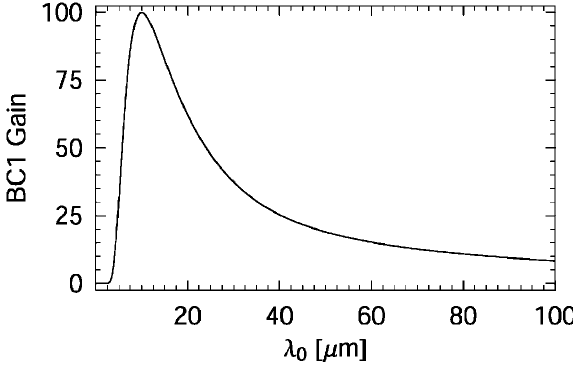
FIG. 3. Microbunching gain after BC1 as a function of the initial modulation wavelength (cid:5)